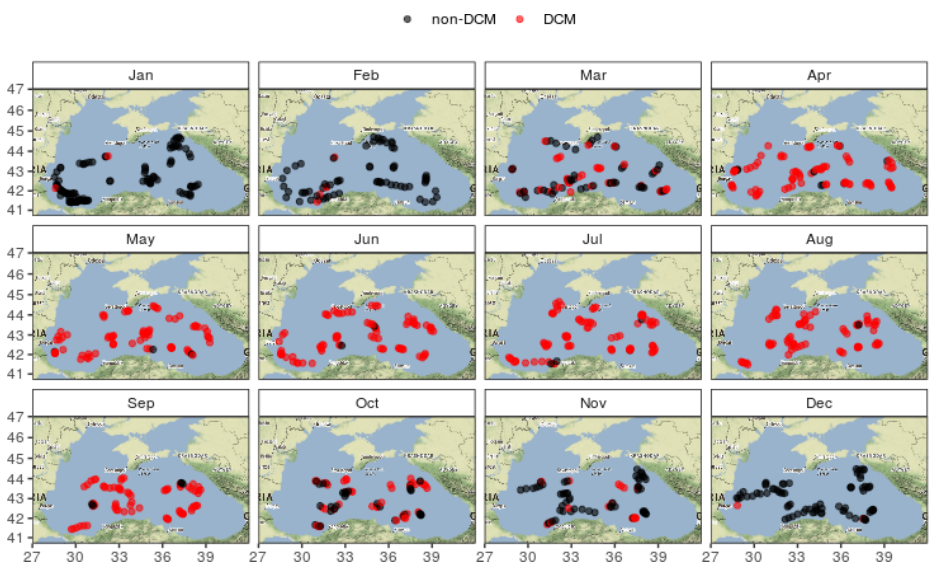
Figure 4. Monthly spatial distribution of DCM and non-DCM profiles indicates homogeneous DCM dynamics in the open basin. This map was created using tiles by Stamen Design, under CC BY 3.0 with data from © OpenStreetMap contributors 2020, distributed under a Creative Commons BY-SA